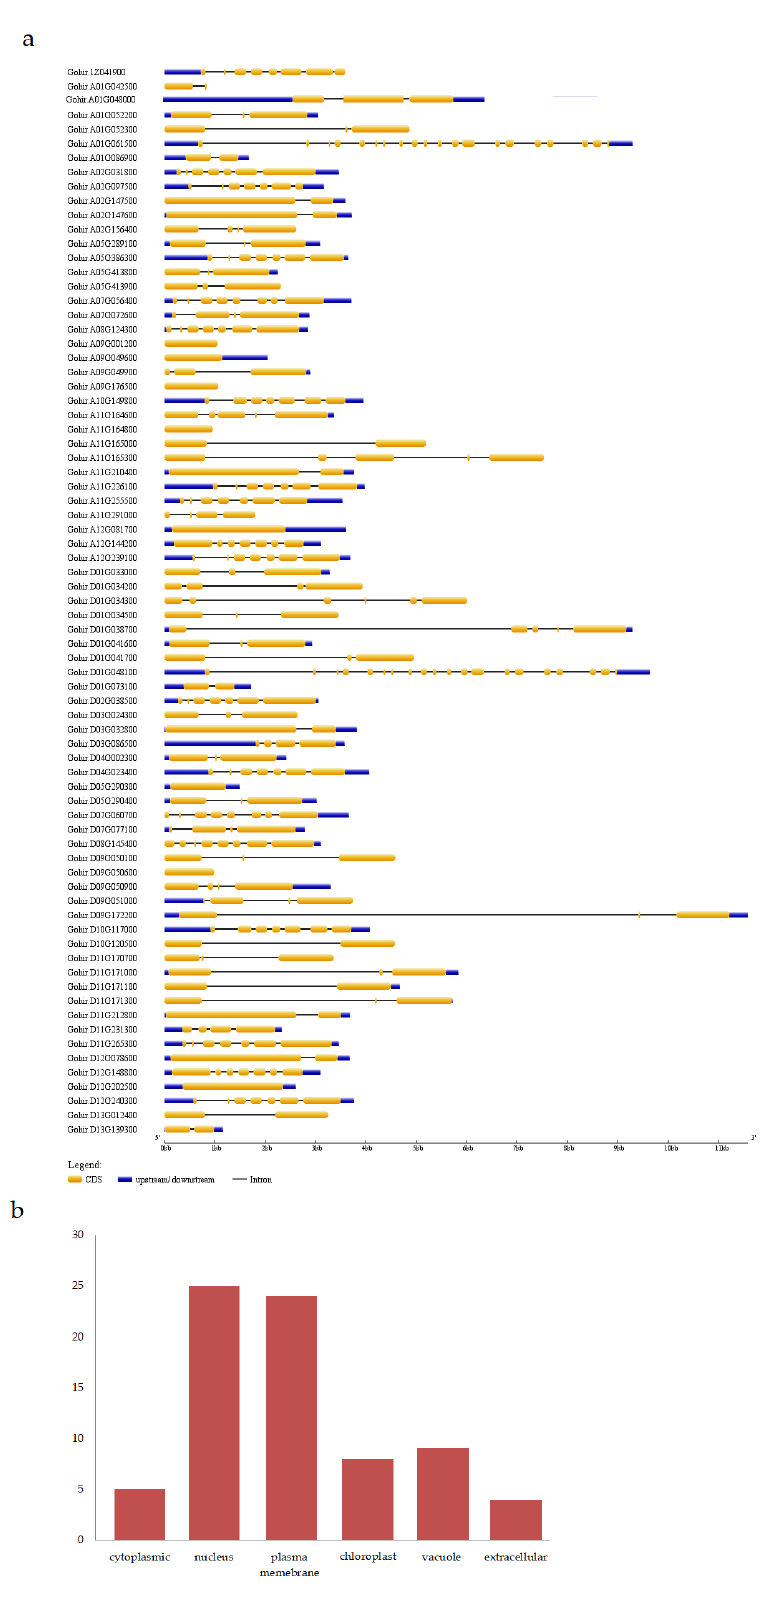
Figure 4. ( a ) Gene structure of G. hirsutum illustrated by GSDS 2.0. Exons are indicated with yellow colored blocks and introns with black linez. ( b ) Gene localization; X-axis indicates number of genes and Y-axis shows different cellular compartments.